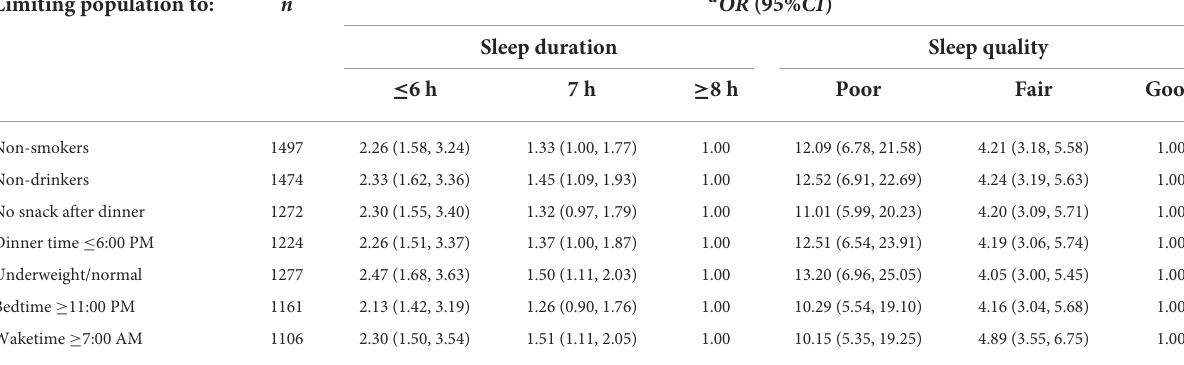
TABLE 4 Sensitivity analyses of the association of suboptimal SRH with sleep duration and sleep quality. Limiting population to: n a OR (95% CI ) Sleep duration Sleep quality ≤ 6 h 7 h ≥ 8 h Poor Fair Good Non-smokers